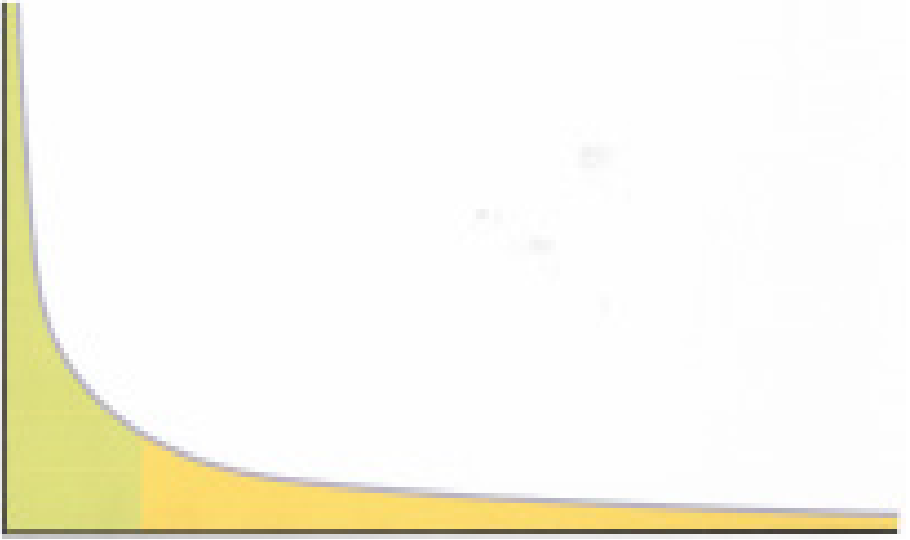
Figure 2. Power law: horizontal axis—persons; vertical axis—number of infections attributed to a particular person; green area—infections by superspreaders—roughly 20% of persons account for about 80% of total infections; yellow area—infections by all other persons—roughly 80% of persons account for 20% of total infections.